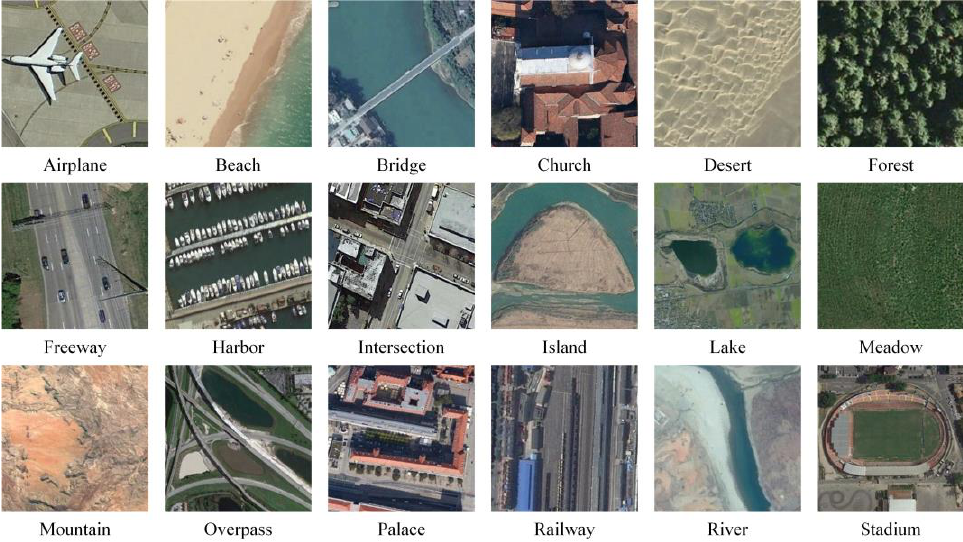
Figure 3. Several scene image samples in NWPU dataset.